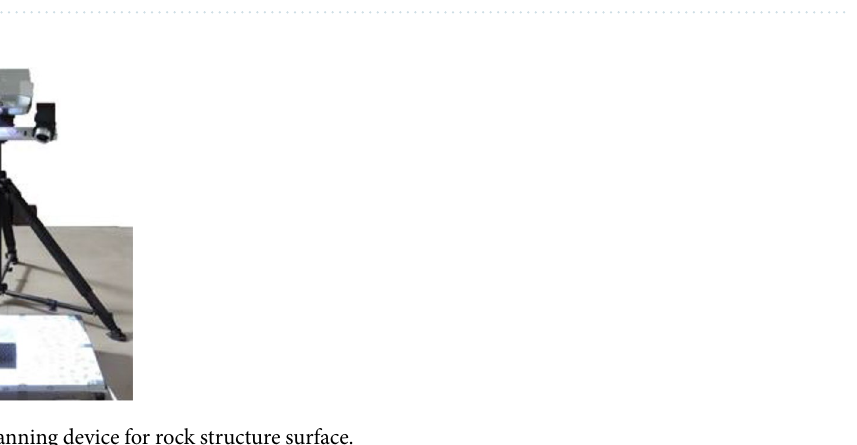
Figure 4. Digitally-controlled shear-flow testing apparatus.